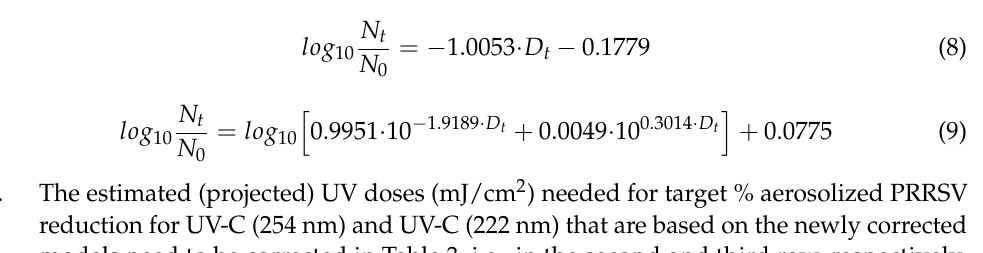
The estimated (projected) UV doses (mJ/cm 2 ) needed for target % aerosolized PRRSV reduction for UV-C (254 nm) and UV-C (222 nm) that are based on the newly corrected models need to be corrected in Table 3, i.e., in the second and third row, respectively.